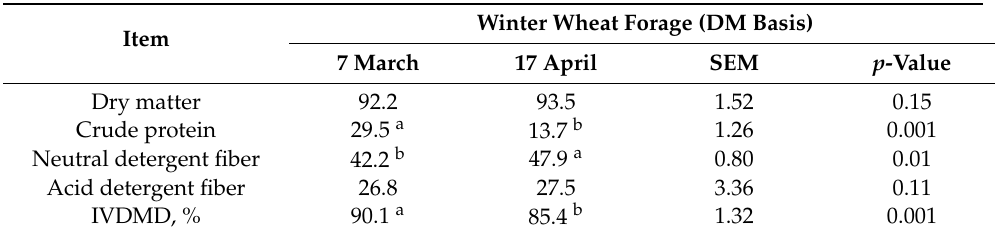
Table 1. Chemical composition and in vitro dry matter (DM) digestibility (IVDMD) of winter wheat forage diets ( n =3). Item